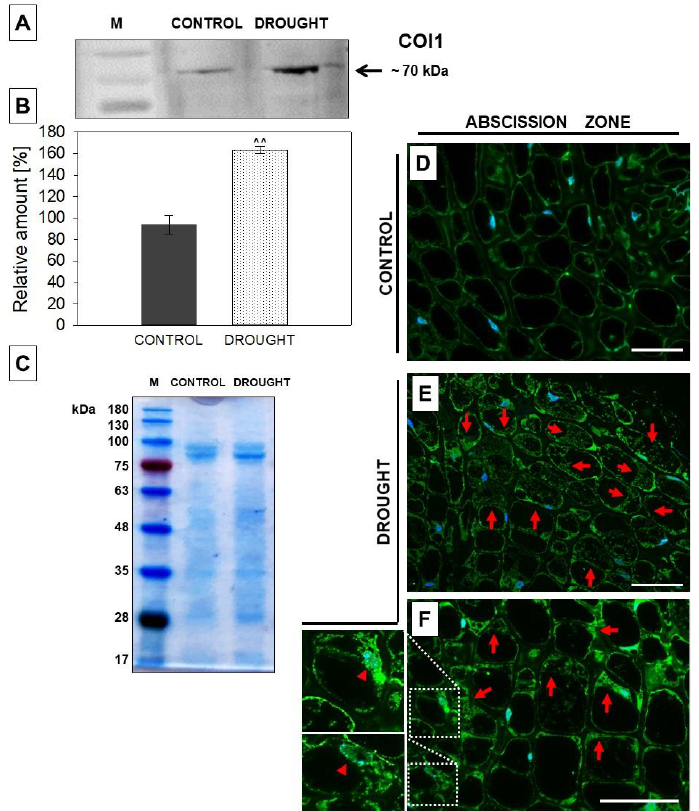
Figure 6. The content of coronatine insensitive 1 (COI1) in the flower abscission zone (AZ) of Lupinus luteus strongly increased under soil water deficit. Flower AZ was harvested from plants growing in the soil of optimal moisture (70% water holding capacity, WHC, control) or drought-stressed lupines (25% WHC). Detailed description in the Material and Methods section. Proteins were isolated and subjected to Western blot analysis with an anti-COI1 antibody, which revealed the presence of a band of ~70 kDa ( A ). Quantitative densitometry analysis was made and presented in ( B ) (100% was set for the control). ^^ p < 0.01 indicates a significant difference. Protein samples were separated by SDS-PAGE and stained with Coomassie Brilliant Blue ( C ). Mass marker (M) is provided on the left, sizes of proteins are displayed in kDa. COI1 antibody was used for immunolocalization analysis performed on control ( D ) and drought-stressed ( E , F ) tissues of AZ from flowers. A green fluores- cence signal, indicated by red arrows, corresponds to the presence of COI1. Nuclei were detected by DAPI (blue color). Enlarged cells of stressed AZ are provided on the left side of the ( F ) image. These are magnified regions marked by white boxes and show colocalization of CO1 with nuclei (red arrowheads). Bars = 40 µM.